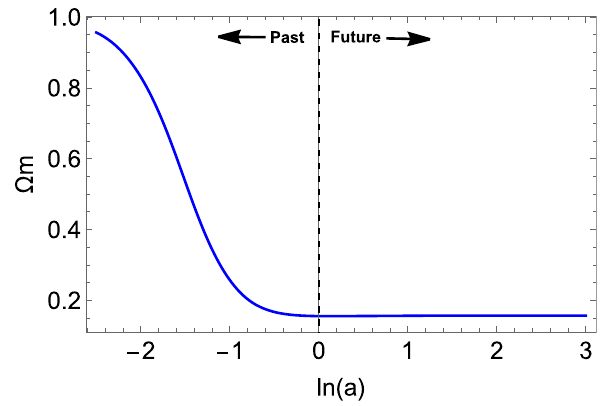
Fig. 5 Late time evolution of DM energy density for an interacting DE–DM model